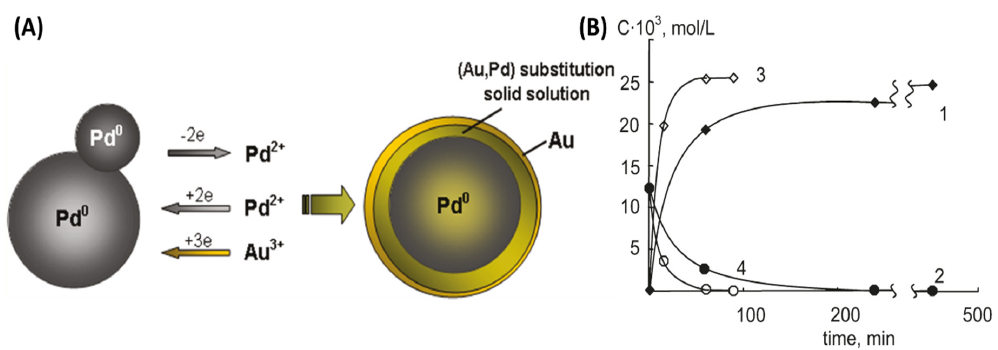
Figure 11. ( A ) Schematic representation for the formation of Pd core-Au shell NPs; ( B ) concentration vs. time (min) dependence for Pd 2+ (1, 3), and Au 3+ (2, 4). Adapted with permission from the American Chemical Society. Copyright 2011 American Chemical Society.